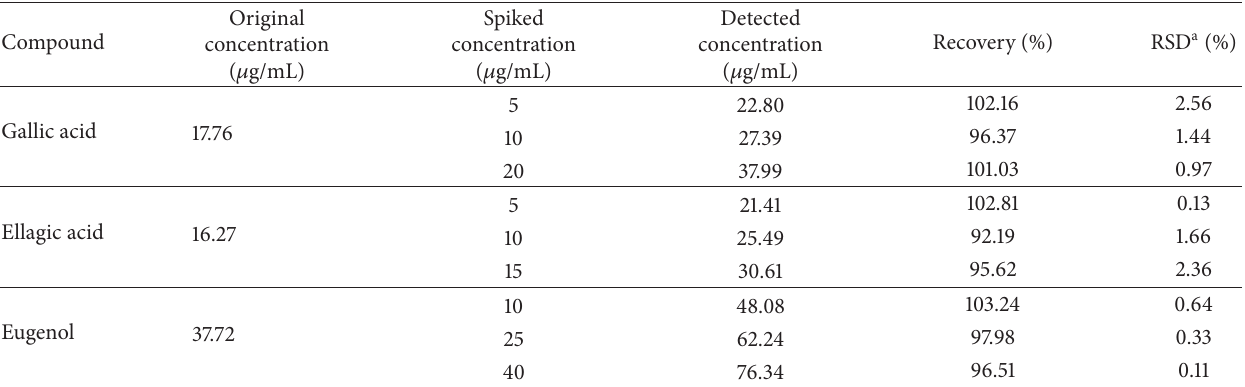
Table 3: Recovery of 3 reference compounds in the Syzygium aromaticum extract ( 𝑛 = 6 ). Compound